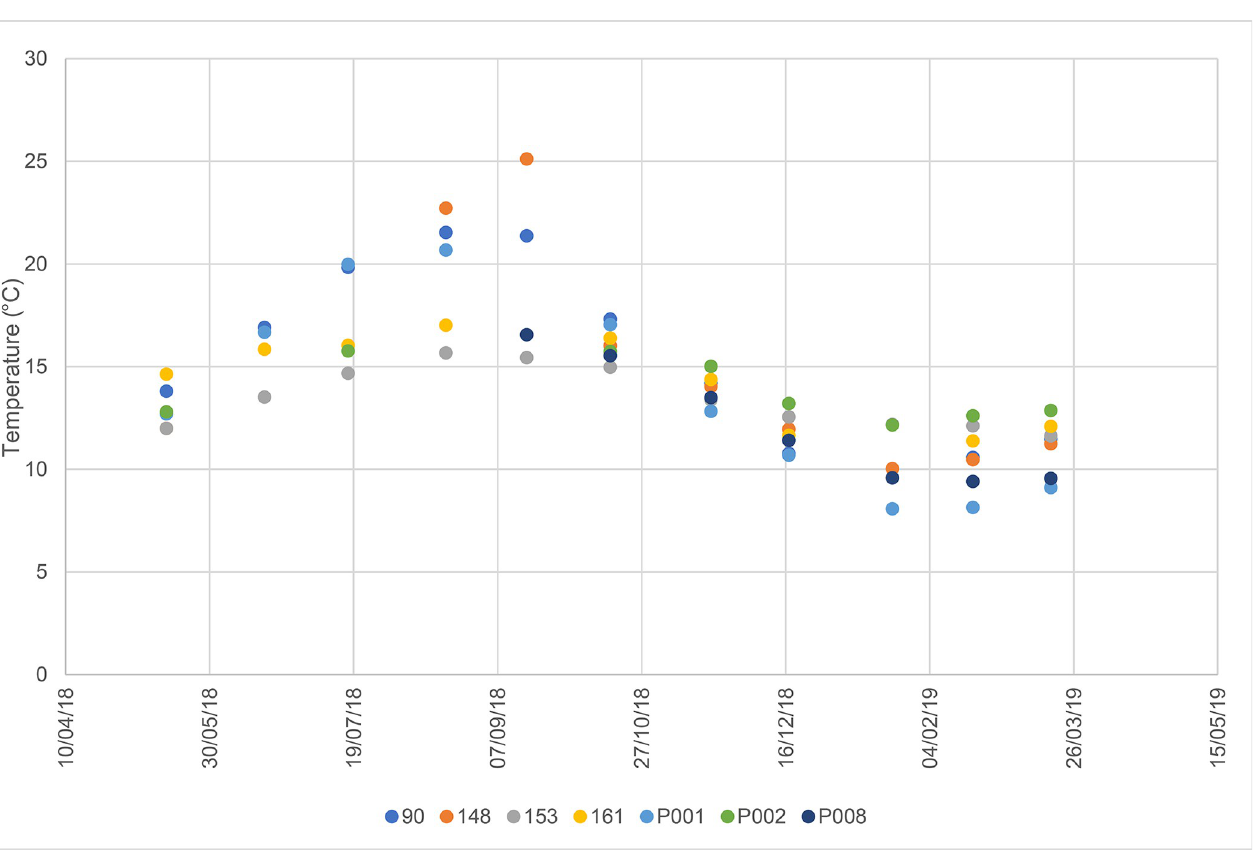
Fig 8. Comparison between thermal fluctuations in spring waters. Dates are given in